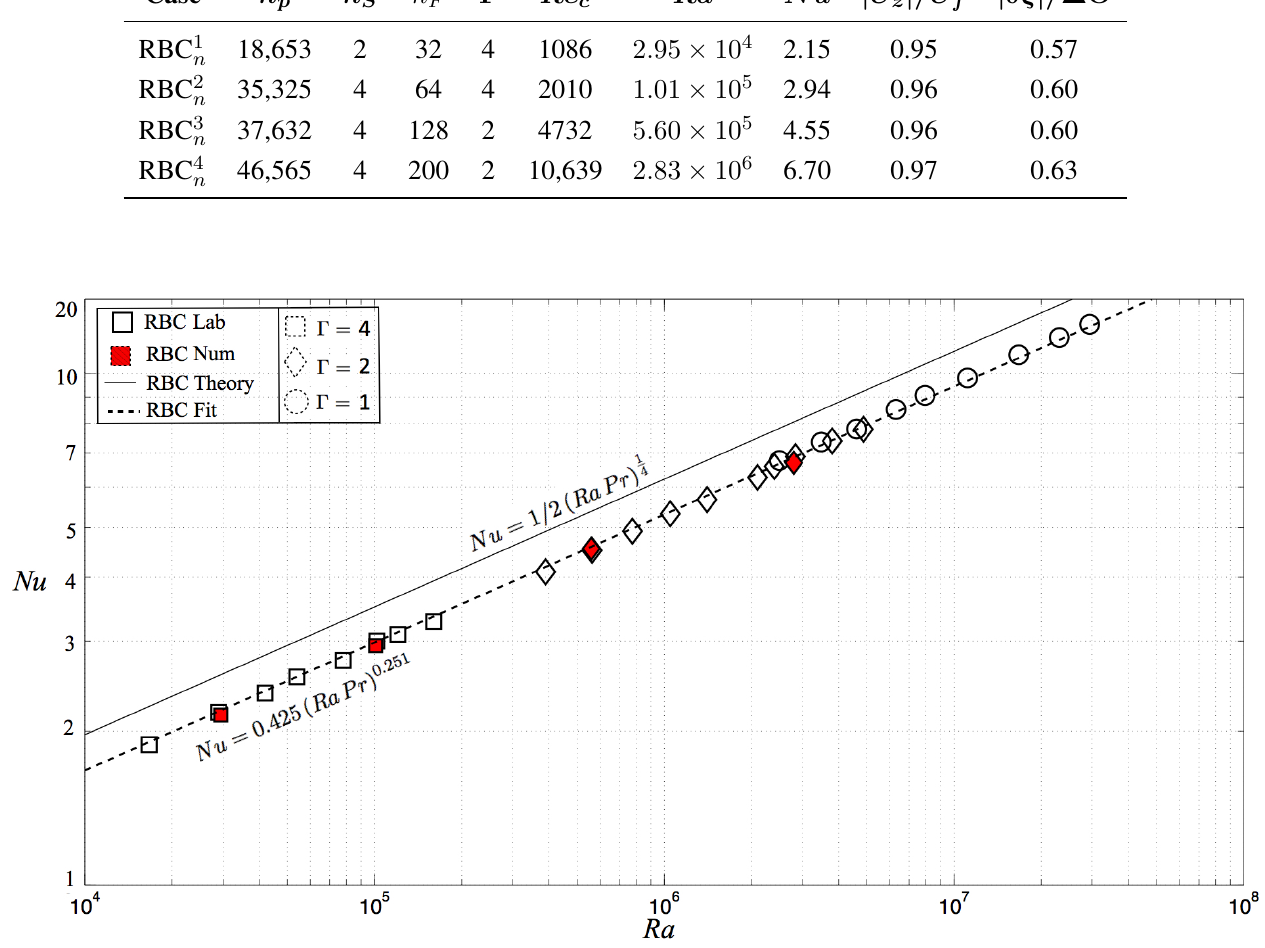
Figure 4. Rayleigh-Bénard convection (RBC) heat transfer measurements in liquid gallium. Heat transfer efficiency, parameterized by the Nusselt number, Nu , is plotted versus the buoyancy forcing, parameterized by the Rayleigh number, Ra . The aspect ratio of the fluid layer, Γ , is shown by the color of each symbol’s edge. Laboratory experimental results have hollow symbols and the red-filled symbols demarcate numerical simulation results. The solid black line demarcates the scaling prediction for low P r inertial heat transfer. The dashed black line shows the best fit to the RBC